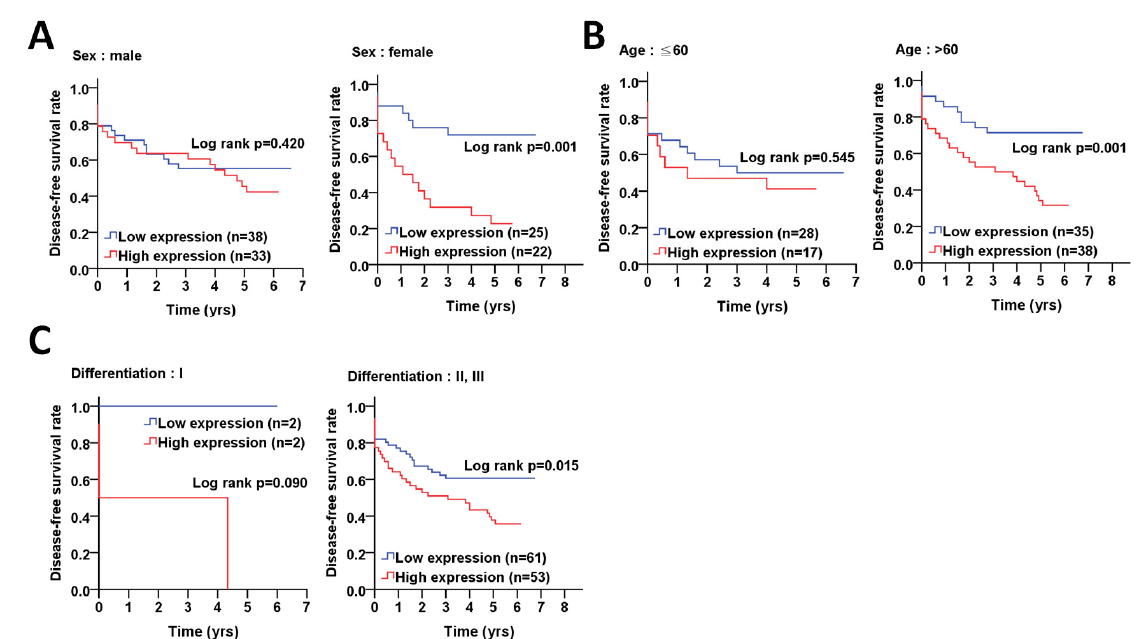
Figure 4. The clinical relevance of ATG5 protein levels on sex, age and differentiation with disease-free survival in colorectal cancer patients. ( A ) Kaplan–Meier plots were used for the stratified analysis to determine the association of ATG5 protein level with disease-free survival based on sex, ( B ) age (60 years old), and ( C ) differentiation. The cutoff values for the high or low ATG5 protein levels in tumor tissues were determined according to the ROC curve. The significance of ATG5 protein levels on survival is shown with log rank.